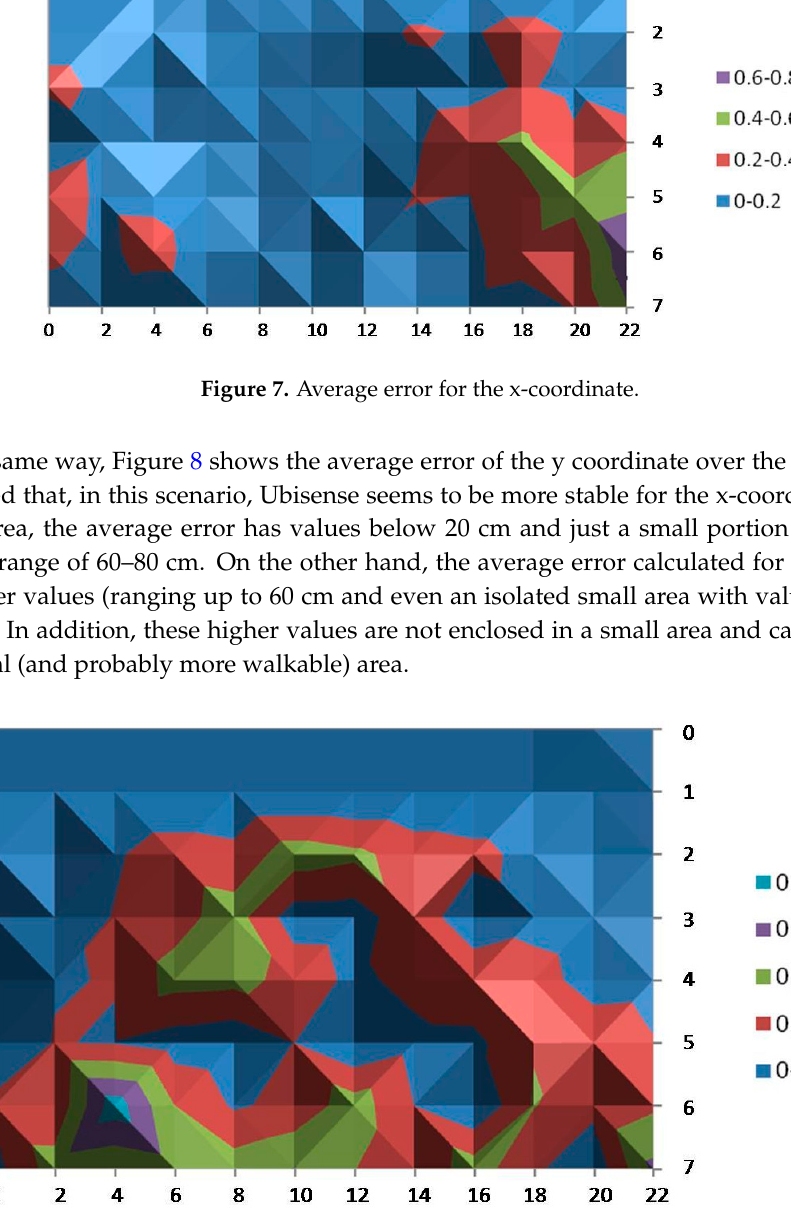
Figure 9. Standard deviation of the samples taken for the x-coordinate.